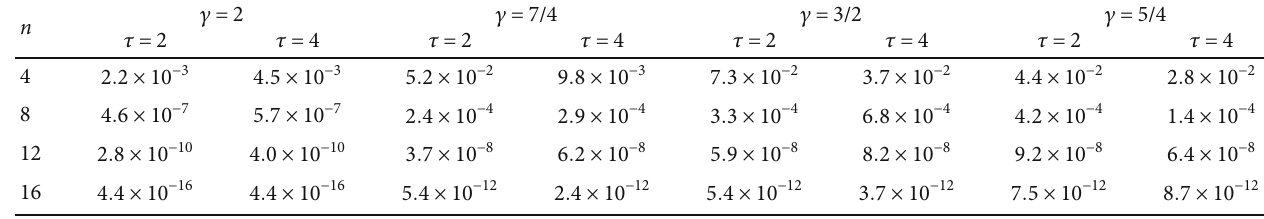
Table 4: The maximum absolute residual error E